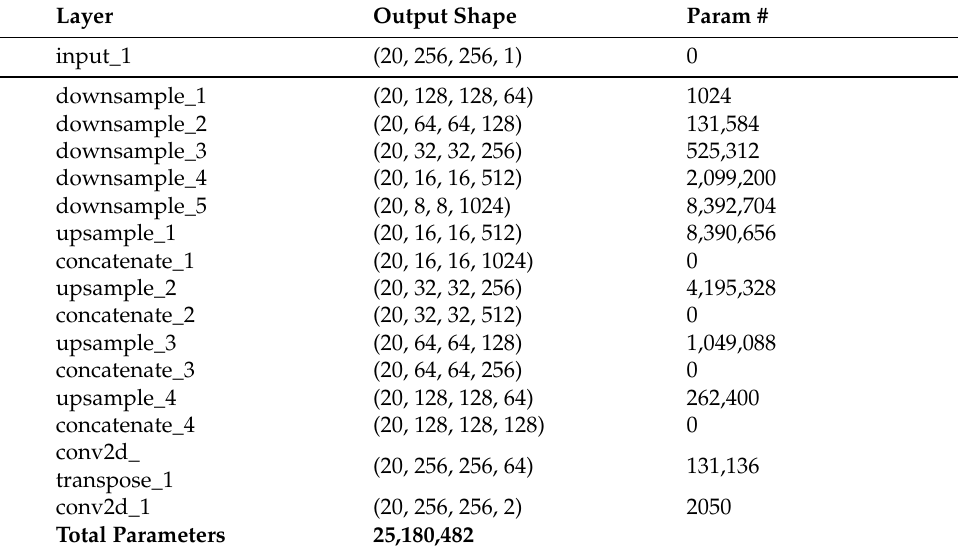
Table A1. Modified UNet architecture for generating IVCF segmentation map. Sequential layers are represented as downsample_x, and upsample_x, where ’x’ represents layer